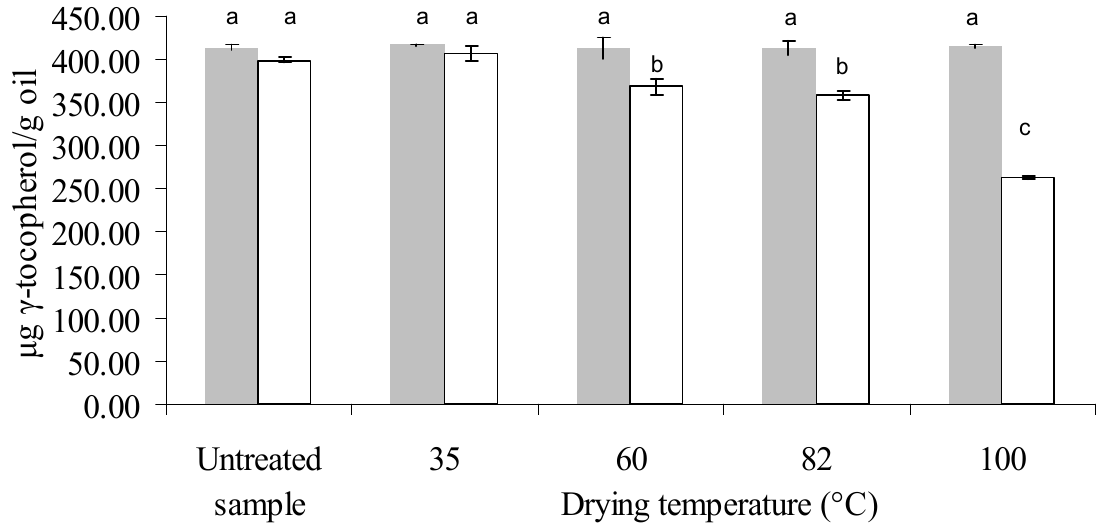
Figure 4. Gamma-tocopherol concentration in the oil extracted from untreated and treated samples of canola, at an initial moisture level of 13.6% db ( ■ ) and 22.7% db ( □ ) and final moisture content of 7% db in all treated samples. Different letters indicate significant differences (Tukey’s test, p < 0.05). Eight independent drying experiments. n (number of replicates of each measurement):